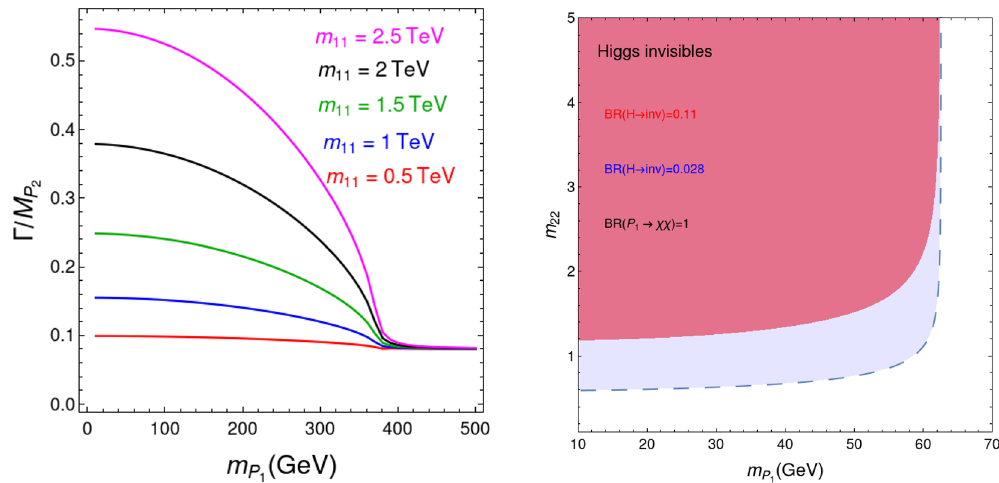
on the lighter pseudoscalar mass for different Figure 7 . Left panel : dependence of Γ( P 2 ) /M P 2 values of m . Right panel : constraints on m originating from the upper limits on the Higgs- 11 22 boson invisible width. The shaded regions blue (red) are ruled out by the current (projected at HL-LHC) constraints on the Higgs to invisible branching